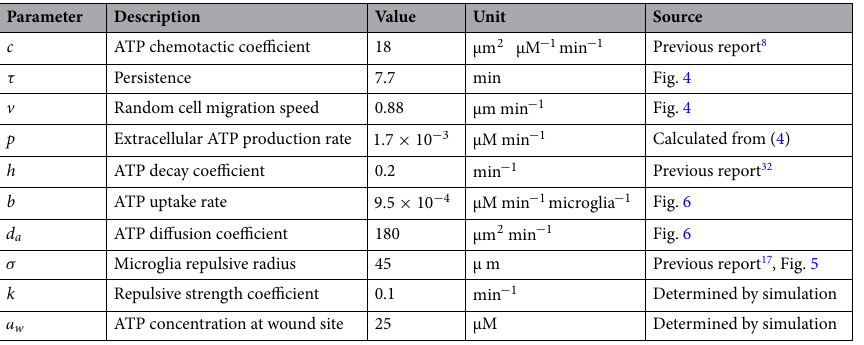
Table 1. Simulation parameter values in the